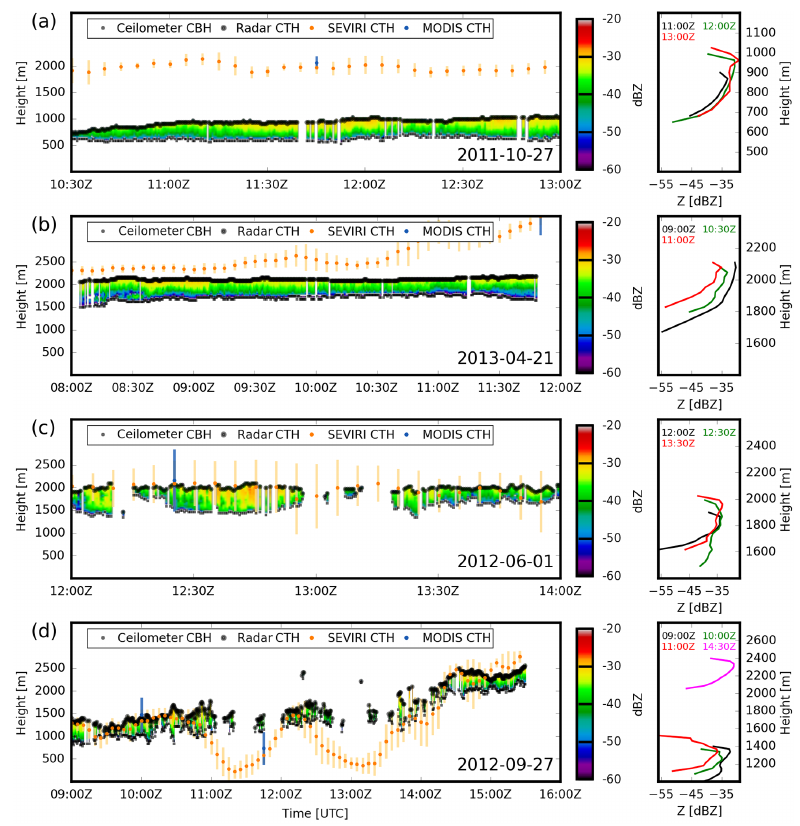
Figure 1. Time series of radar reflectivity Z(z) (in dBZ) and cloud boundaries for the four cases listed in Table 2; (a) 27 October 2011, (b) 21 April 2013, (c) 1 June 2012, (d) 27 September 2012. Cloud borders are shown as detected by Cloudnet with black dots and by SEVIRI using NWC SAF in orange dots, and MODIS in blue dots. Sample profiles of Z(z) are shown at different times during each